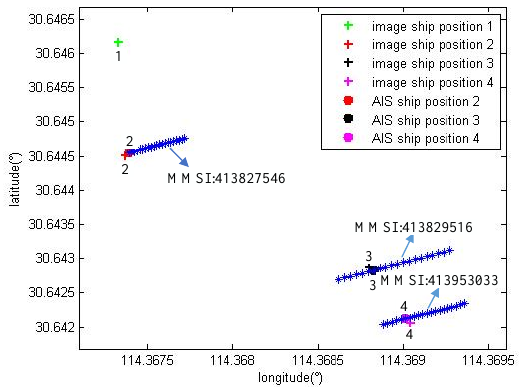
Figure 14. The results of the point to track matching algorithm for the identification of four vessels.